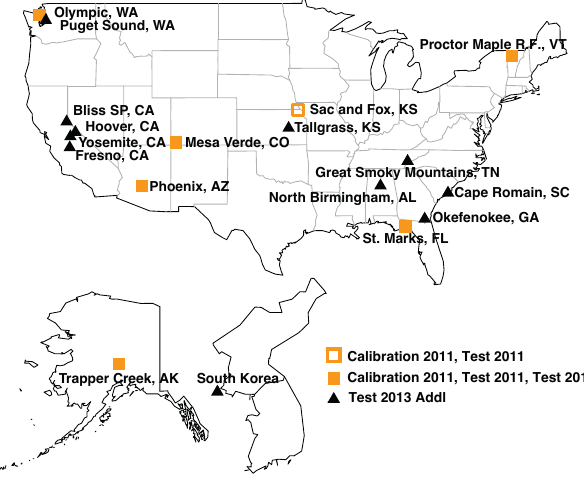
Figure 1. IMPROVE network